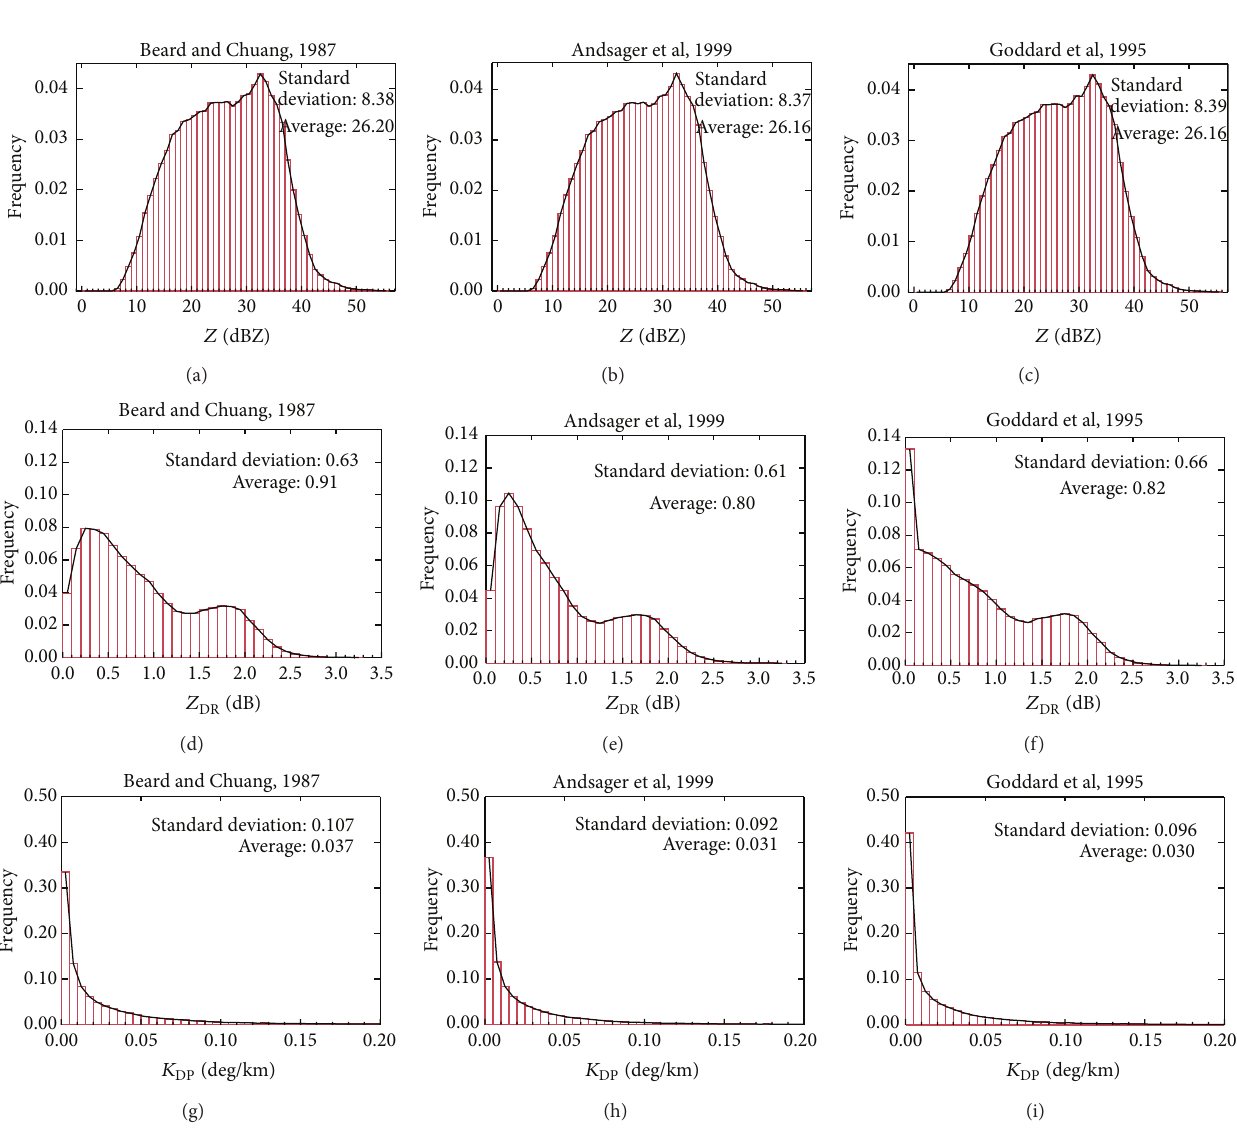
Figure 5: The occurrence frequency of (a) 𝑍 with DS1, (b) 𝑍 with DS3, (c) 𝑍 with DS6, (d) 𝑍 DR with DS1, (e) 𝑍 DR with DS3, (f) 𝑍 DR with DS6, (g) 𝐾 DP with DS1, (h) 𝐾 DP with DS3, and (i) 𝐾 DP with DS6.